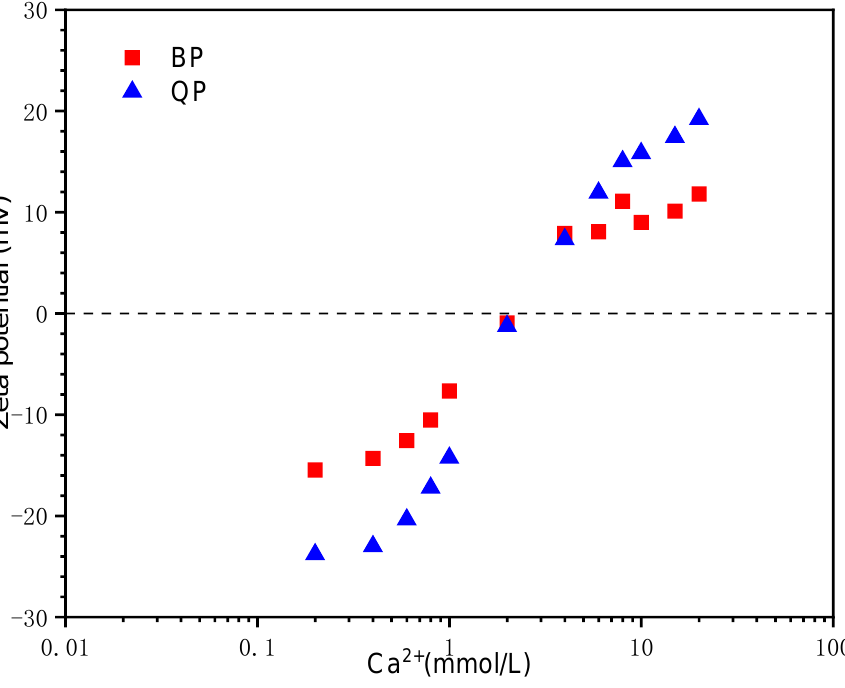
Figure 5. Zeta potential of BP and QP in Ca(OH) 2 solutions.